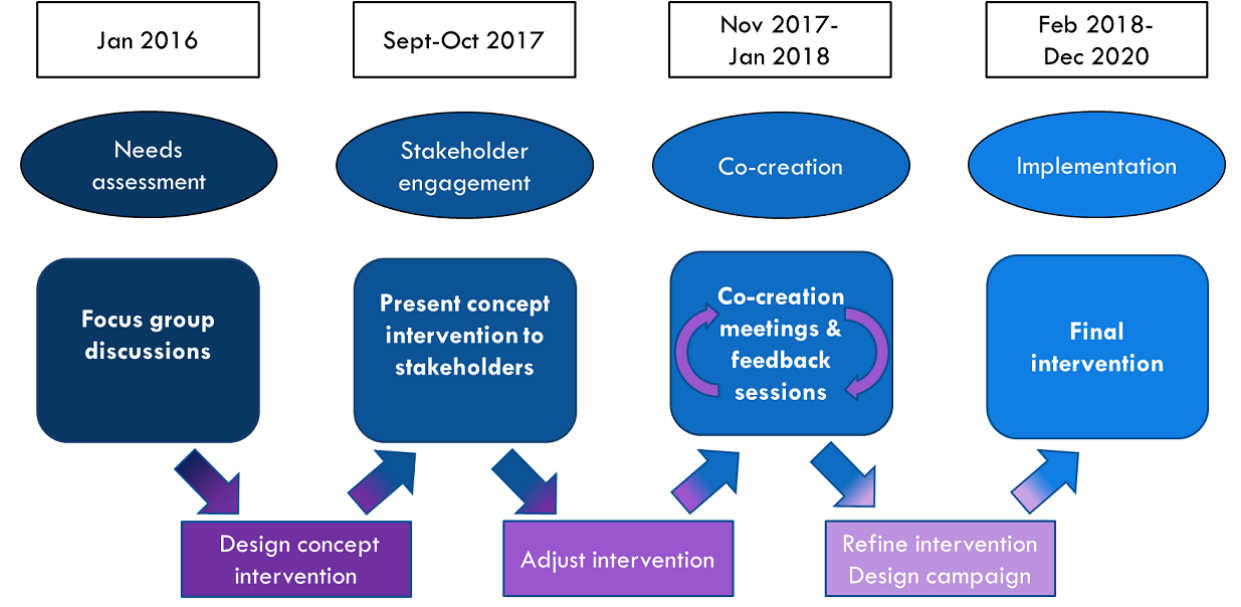
Figure 1. Flow chart of the co-creation process leading to the implementation of the final